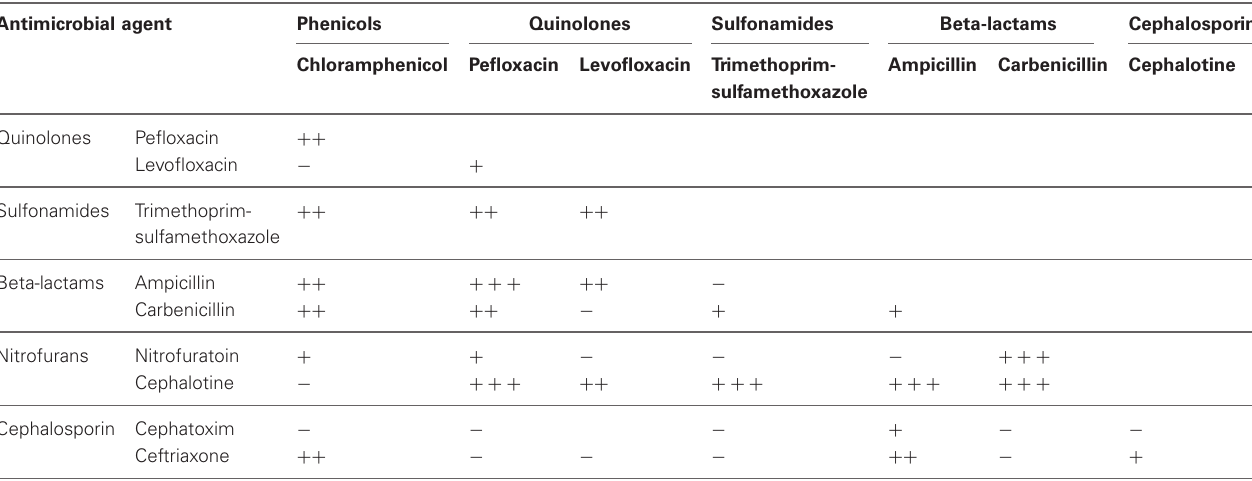
Table 5 | Association between antimicrobial resistance phenotypes of E. coli isolates from stream water. Antimicrobial